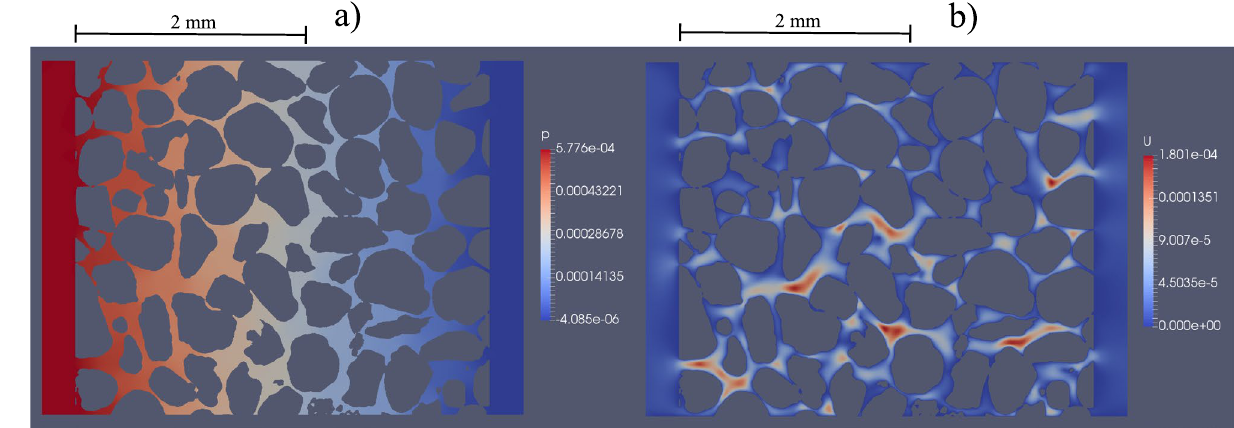
Figure 2. Simulated water transport through sample 1d shown at a central cross-section of the sample: (a) kinematic pressure field p [m 2 s −2 ], (b) velocity magnitude field U [m s −1 ] (figure created using Paraview 5.3 software https ://www.parav iew.org/).